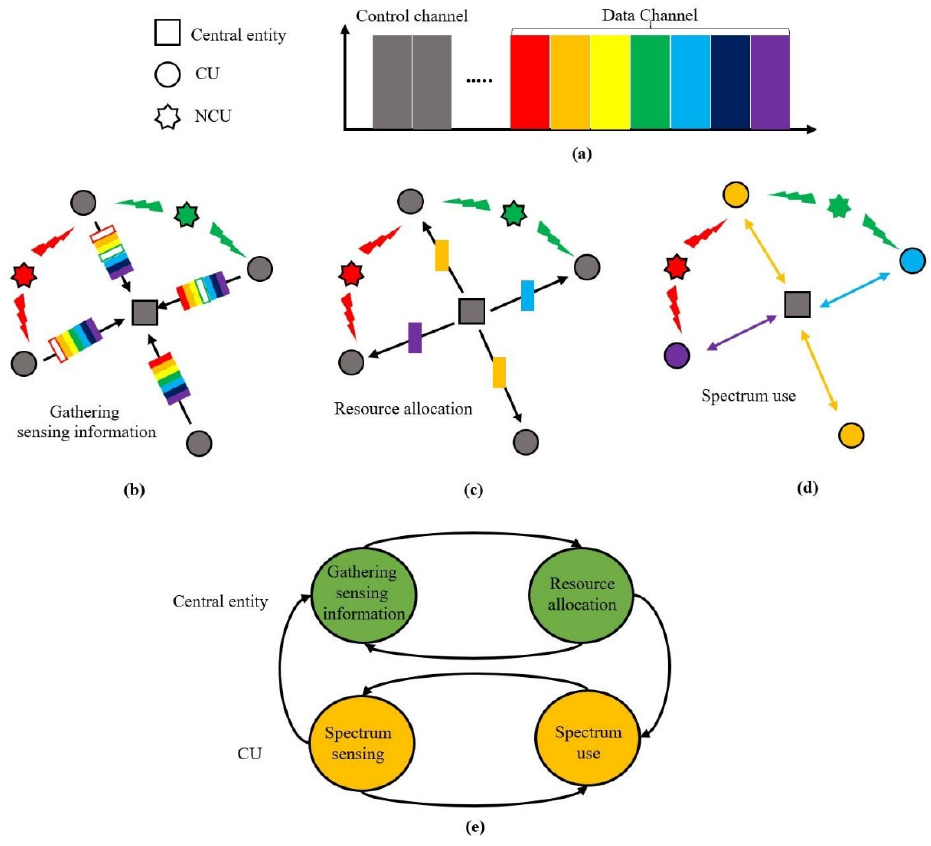
Figure 1. A scenario of spectrum sharing for a UCAN: ( a ) channels; ( b ) an illustration of gathering sensing information; ( c ) an illustration of resource allocation; ( d ) an illustration of spectrum use; ( e ) the state transition diagram of spectrum sharing processes.